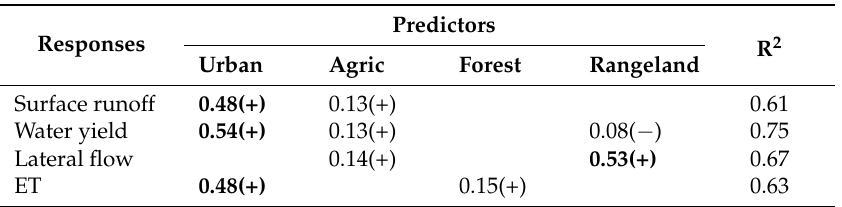
Table 10. Responses of four hydrologic components to individual LULC types (predictors), values represent partial R 2 with +/– indicating direction of